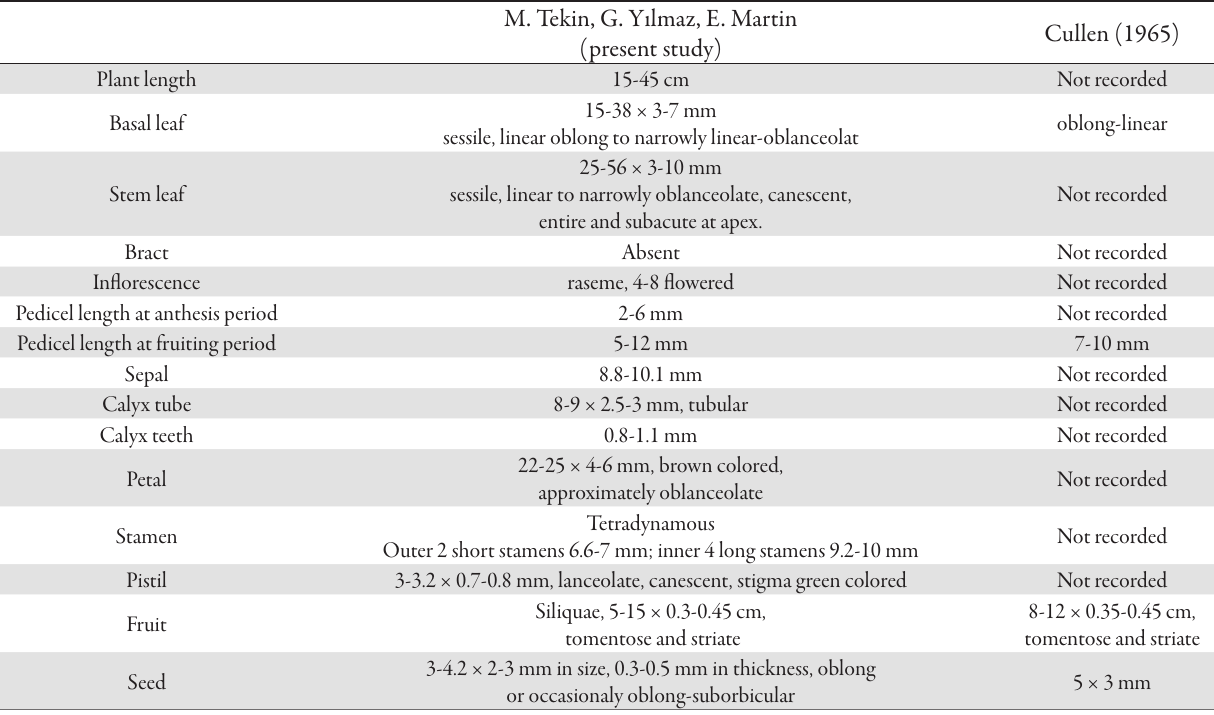
Tab. 1. The comparison with literature knowledges of the morphological characters obtained from Matthiola anchoniifolia